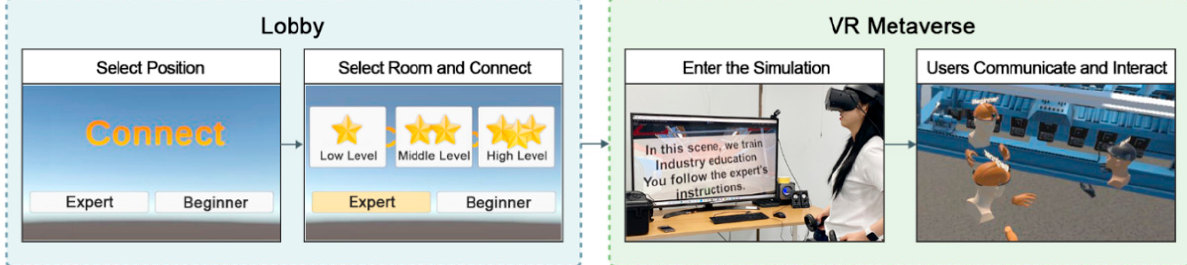
Figure 3. Demo test procedure.